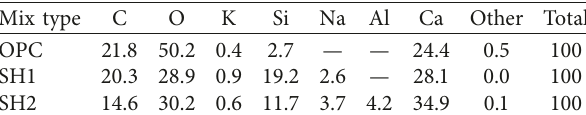
Table 6: EDS analysis results of mortar crack